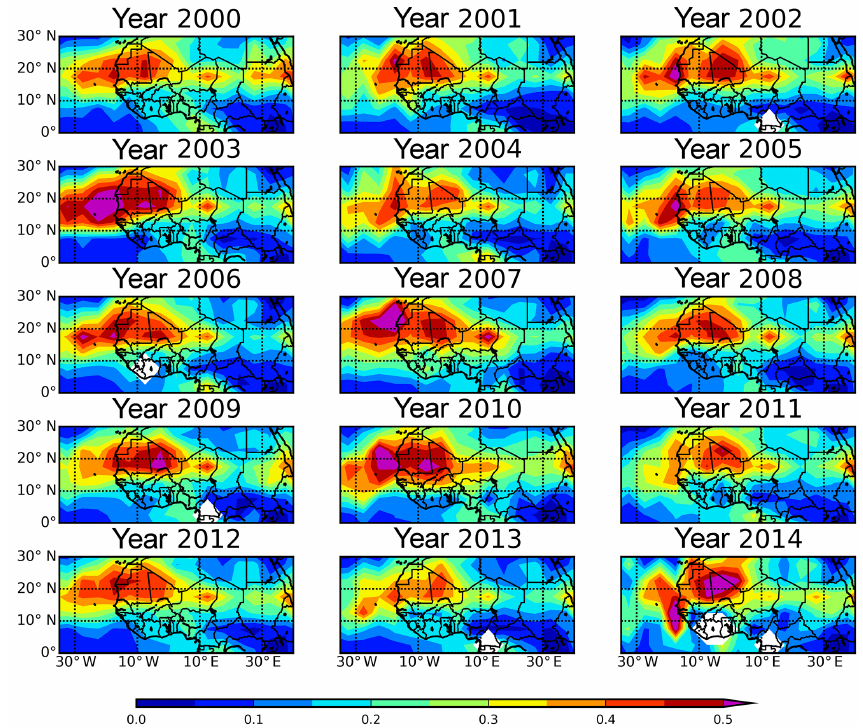
Figure 5. Monthly mean optical depth of the nonspherical aerosols from MISR in July for 15 years between 2000 and 2014. The white blank spots indicate that there were no retrieved nonspherical AOD values for the